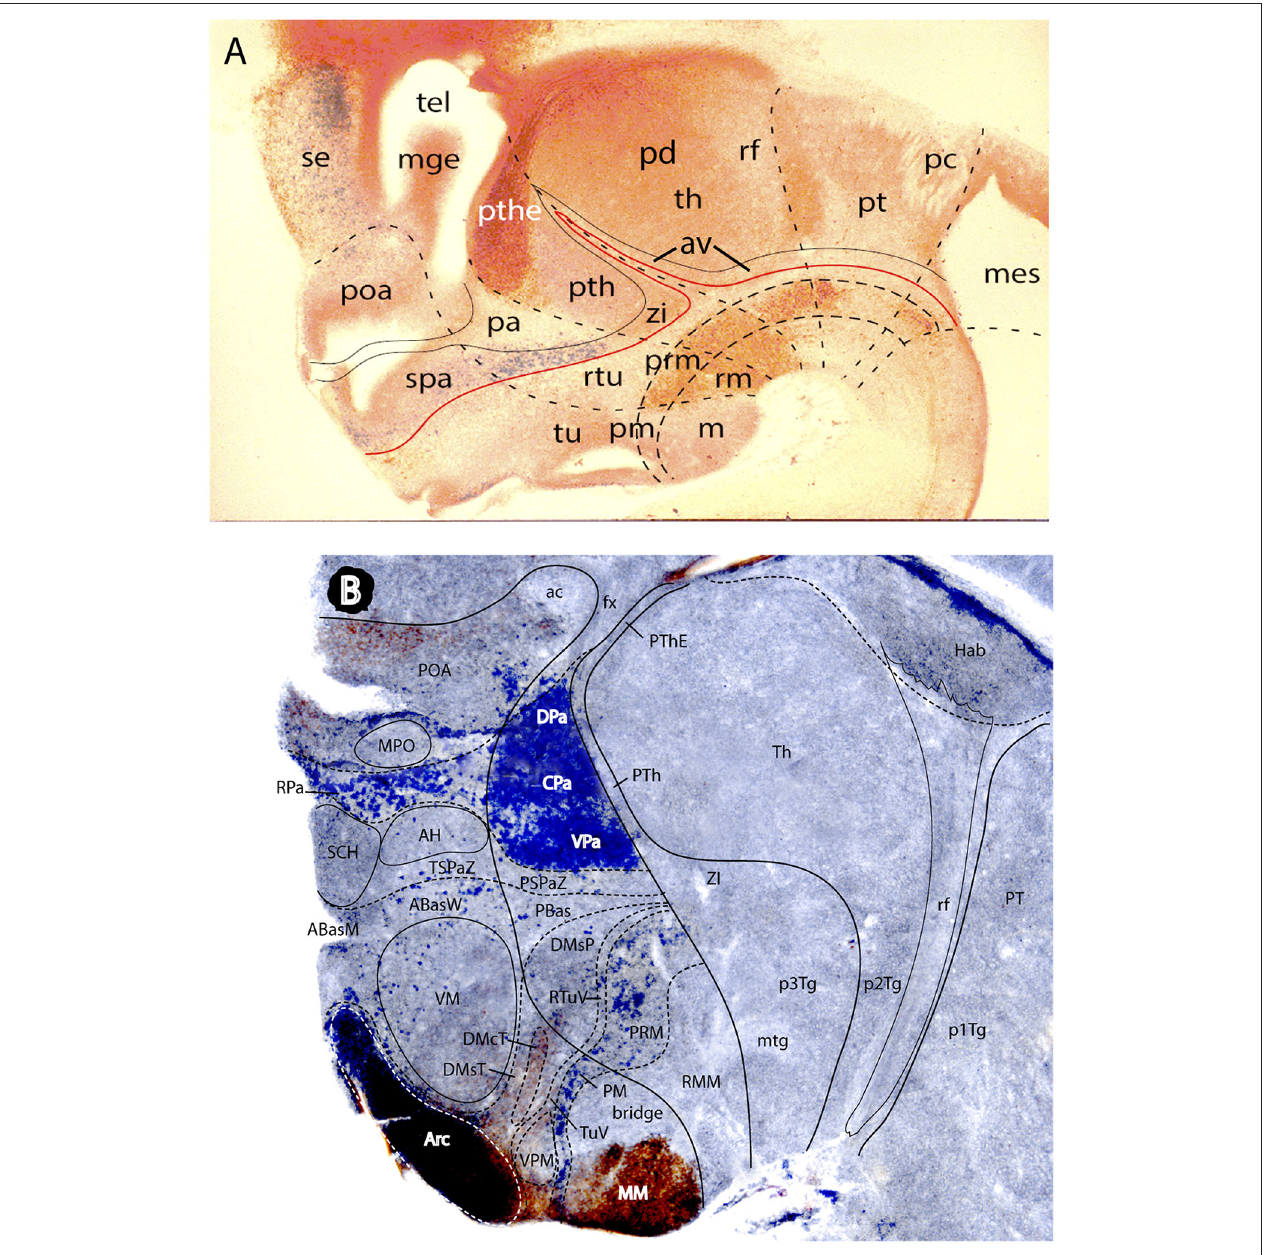
FIGURE 13 | Two mouse brain sagittal sections reacted genoarchitectonically to visualize prethalamic and hypothalamic subdomains in a broader forebrain context (particularly diencephalic). Material extracted and slightly modified from (Puelles L. et al., 2012a) no copyright permission required). (A) Is a E16.5 mouse embryo sagittal section showing weak Dlx5/6-LacZ blue reaction at sites of Dlx gene expression e.g., the hypothalamic subparaventricular area (spa), continuous caudally with the prethalamic zona incerta area (zi), the latter being also continuous over the Nkx2.2 -positive shell domains of the zona limitans (compare Figure 5C ) with further alar areas always next to the basal plate down to the midbrain (this band coincides with sites producing GABAergic neurons). Calretinin immunoreaction was combined in (A) (brown reaction), to highlight the prethalamic eminence subregion (pthe) as well as some partial basal plate patterns across hp1, dp3, and dp2. The dash lines mark interprosomeric boundaries running from roof to floor. Note retroflex tract (rf) and posterior commissure (pc) as boundary-related landmarks. The alar prethalamus appears accordingly divided into three dorsoventral subdomains, namely the prethalamic eminence (pthe), the subjacent area occupied by the major prethalamic derivatives (reticular nucleus, and the pregeniculate and subgeniculate visual centers—marked “pth”) and the zona incerta area (zi). Note the underlying prethalamic tegmentum (separated by the red alar-basal boundary) is also divided into three dorsoventral subdomains (longitudinal dash lines), which also extend throughout the whole forebrain. The hypothalamic alar plate, in contrast, is divided only into two dorsoventral zones, the paraventricular area (pa) and the subparaventricular area (spa). The pa has a sharp molecular boundary with the alar prethalamus (pth); see also (B) . It is larger dorsoventrally within hp1, whereas the spa is larger within hp2 (peduncular vs. terminal hypothalamus; compare Figure 10 ). The basal plate hypothalamic territory is divided dorsoventrally in three